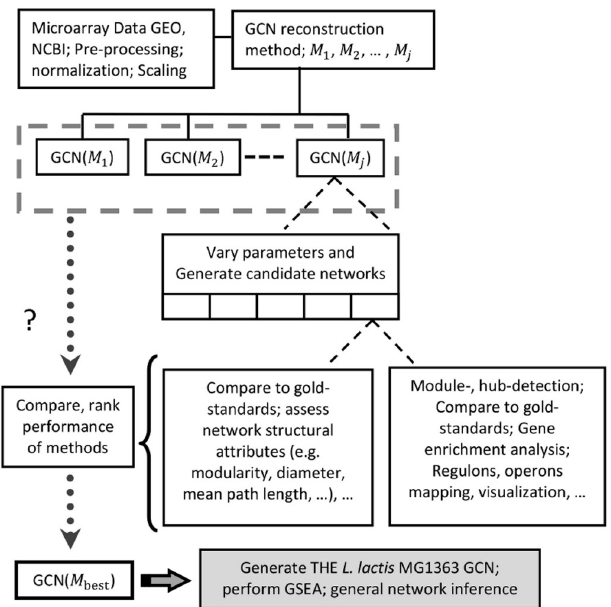
Fig 1. Workflow of gene co-expression network (GCN) reconstruction using different